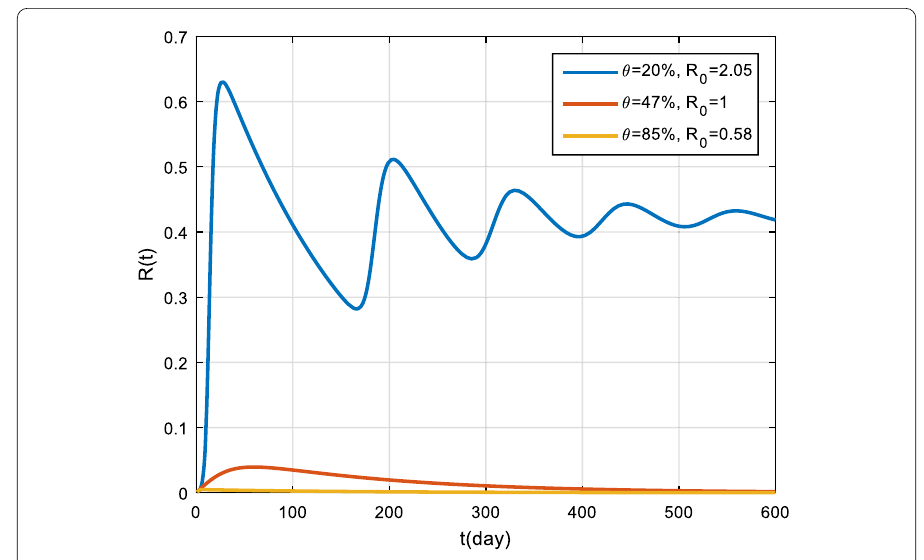
Figure 10 Variation in the number of recovered population for different values of θ